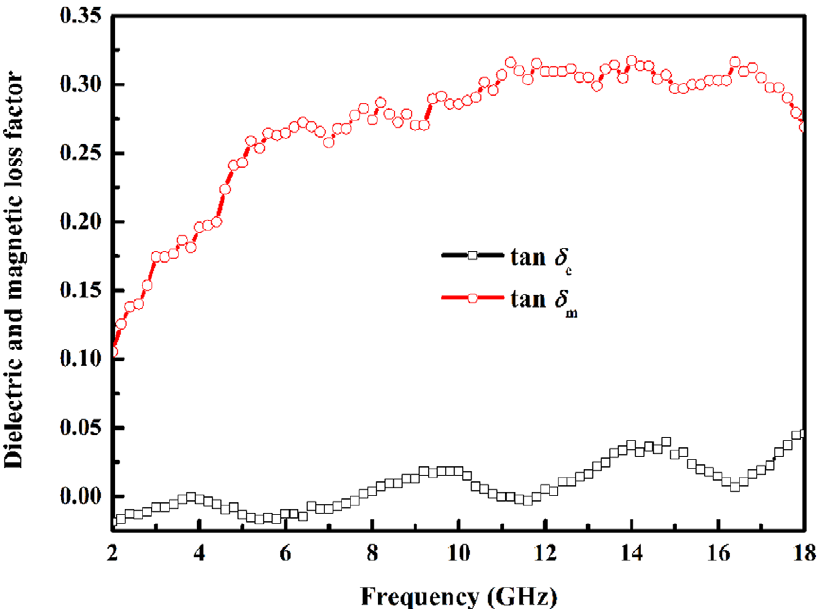
Figure 5. The dielectric loss factor (tan d e ) and magnetic loss factor (tan d m ) of chain-like Co flower.